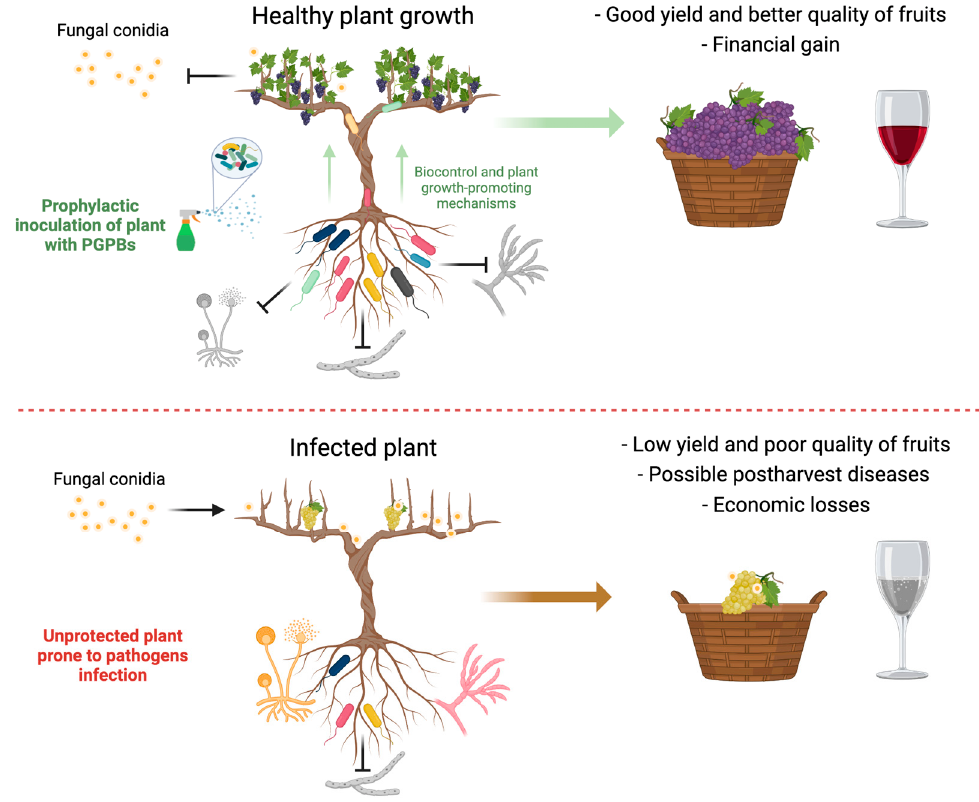
Figure 3. An illustration of two possible scenarios, depending on the preventive application or not of plant growth-promoting bacteria in crops (see text for details). Table 2. Available biofungicides based on antagonistic bacteria for the control of grey mould disease caused by Botrytis cinerea (and other potential fungal plant